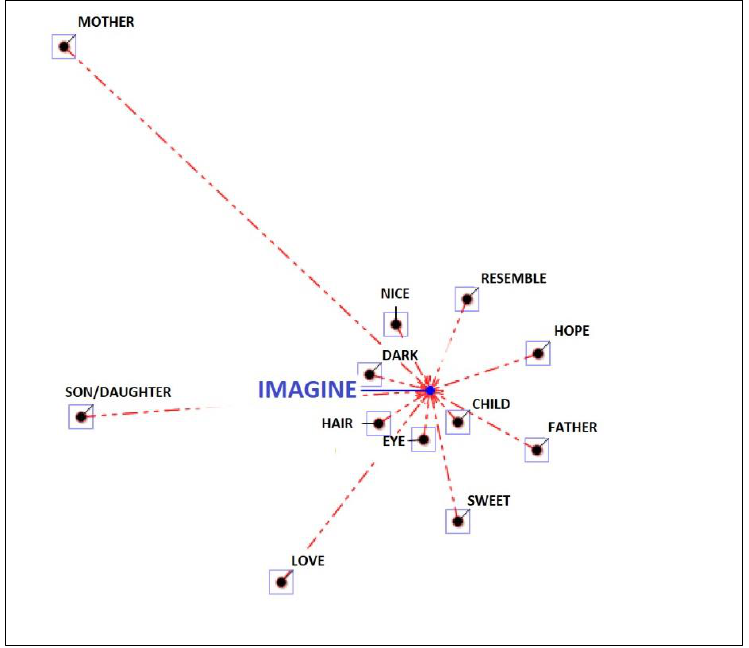
Figure 7. Associations to the theme “future”.